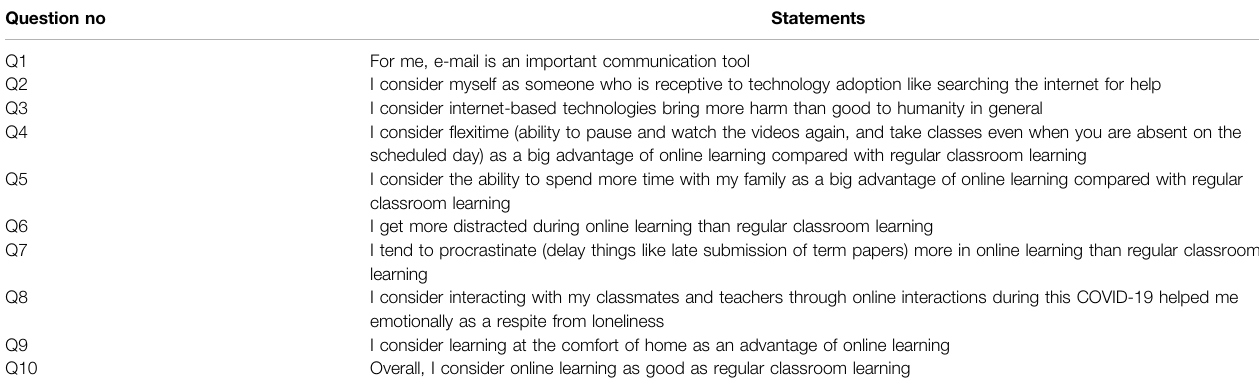
TABLE 1 | Speci fi c statements to which the survey asked for the agreement (Agree or